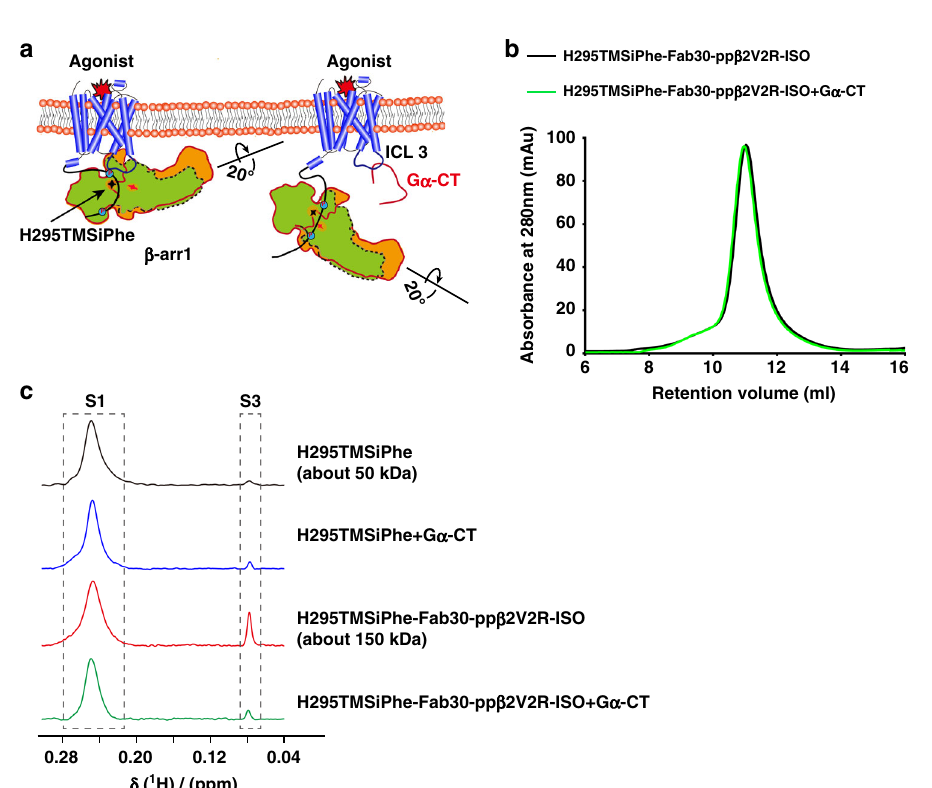
Fig. 5 G α -CT competition experiments. a Schematic diagram of the interaction between GPCRs and β -arr1 in the presence of excess G α C-terminus (G α - CT), which has been described in previous reports 47 . The interaction between β -arr1 and the GPCR TM core was abolished via steric hindrance by G α -CT. β -arr1 still interacts with the phosphorylated GPCR C-terminal tail and thus forms a complex with the receptor. The blue circles indicate the phosphorylation. The Shuriken indicate the position of H295TMSiPhe in inactive (black) and active (red) β -arr1. b ISO/pp β 2V2R/ β -arr1/Fab30 complex formation was not disrupted by G α -CT in a size-exclusion assay. The similar SEC pro fi le observed with or without G α -CT suggests that G α -CT did not disrupt the ISO/pp β 2V2R/ β -arr1/Fab30 complex. Size-exclusion chromatography experiments were performed on an AKTA Puri fi er equipped with a Superdex 200 (10/300 GL) column. Black: ISO/pp β 2V2R/ β -arr1-H295TMSiPhe/Fab30 complex, green: ISO/pp β 2V2R/ β -arr1-H295TMSiPhe/Fab30 complex mixed with the 200 μ M G α -CT. c 1D 1 H NMR spectra of β -arr1-H295TMSiPhe in the presence of G α -CT. The transformation from S1 to S3 induced by the ISO/pp β 2V2R/ β -arr1/Fab30 complex was signi fi cantly weakened by the addition of G α -CT, suggesting the observed S3 state reduction was mainly caused to the elimination of the receptor core interaction with β -arr1 by the binding of G α 7TM core-mediated conformational change in β -arr1 . To structures of the rhodopsin/arrestin, rhodopsin/G α -CT, and con fi rm that the observed S3 signal in the DeSipher spectrum was rhodopsin/ArrFl (arrestin- fi nger loop peptide) complexes have dependent on the interaction of β -arr1 with the receptor core, we revealed a signi fi cant overlapping interface of the receptor 7- performed a competition assay using a well-characterized binding transmembrane core with the fi nger loop of arrestin and G α -CT partner of the receptor 7-transmembrane core, namely, the G α of G-protein 45,47 . Moreover, direct engagement of the β -arr1 fi nger loop and G α -CT of G-protein serves as a major interaction protein C-tail (G α -CT) (Fig. 5a). Recently, obtained crystal